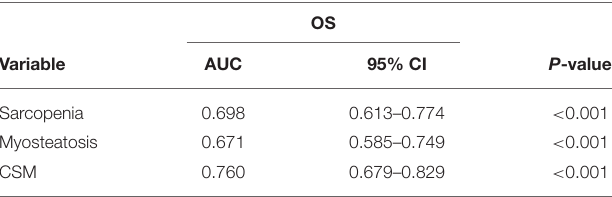
TABLE 5 | The AUCs of sarcopenia, myosteatosis, and CSM for OS and prediction based on the ROC results.